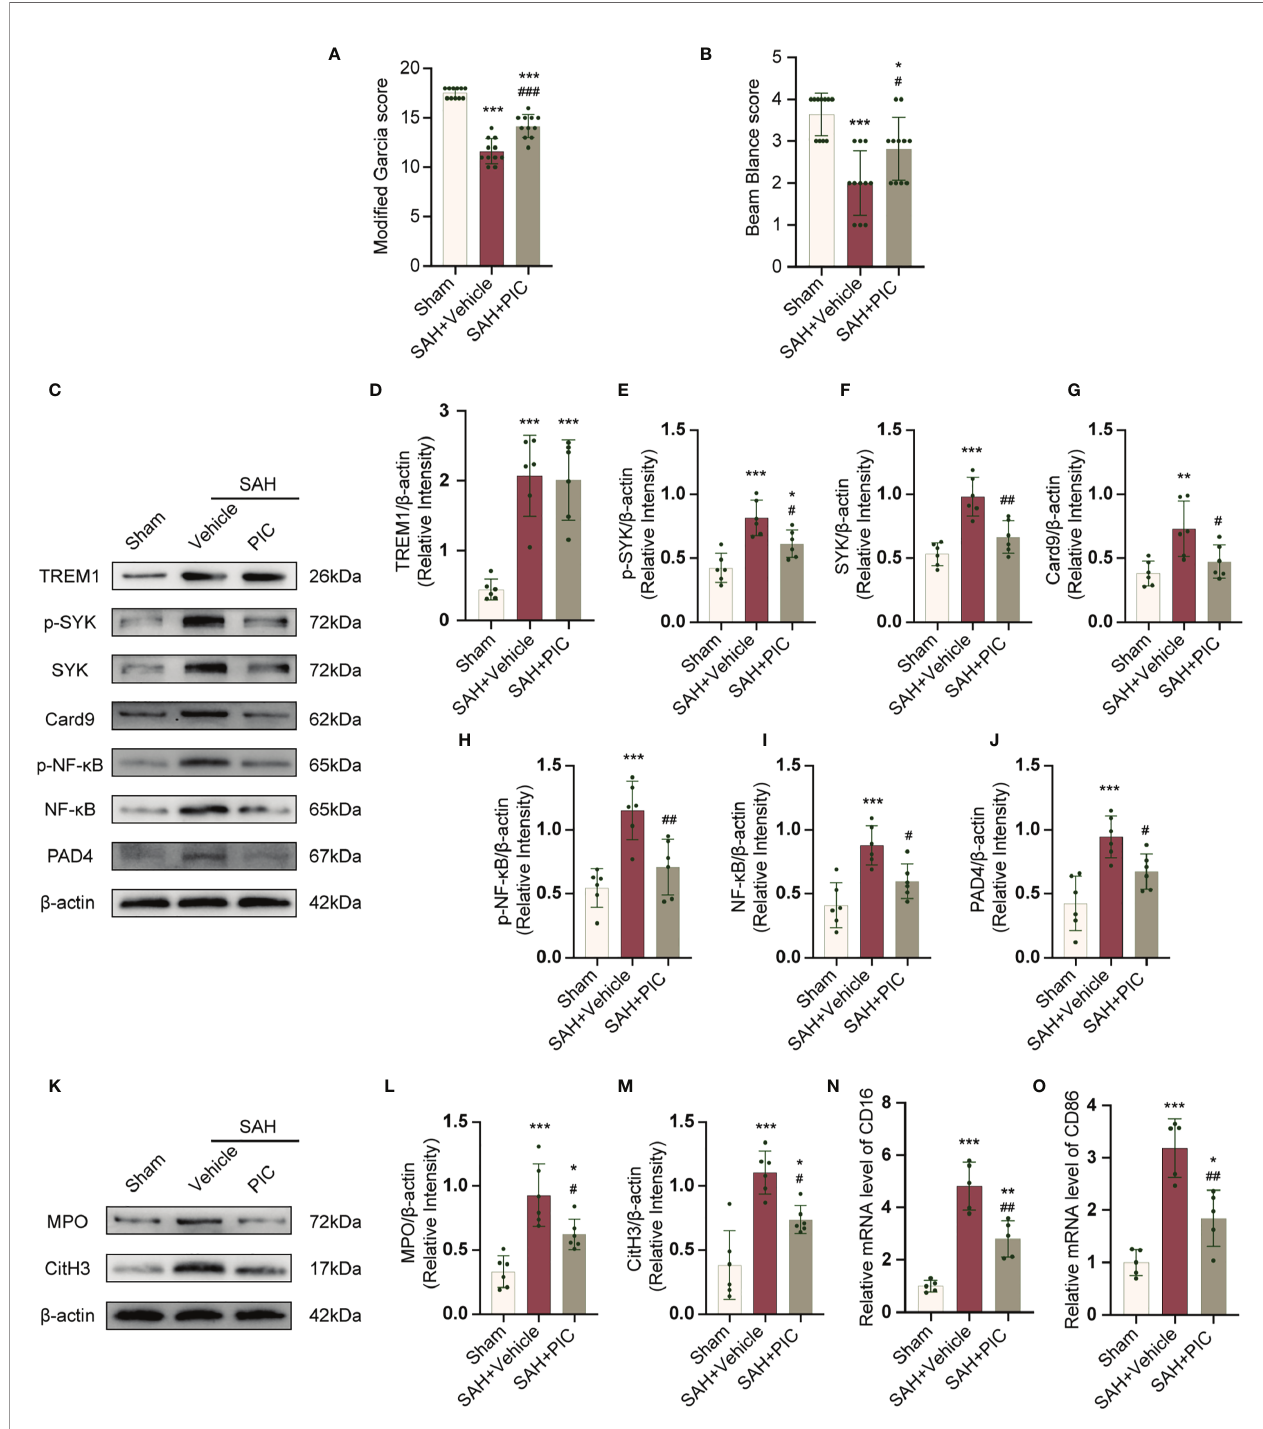
FIGURE 8 | TREM1-induced SYK activation triggered proin fl ammatory subtype microglia and the formation of NETs after SAH. (A, B) Quanti fi cation of neurological function (modi fi ed Garcia score and beam balance test) at 24 h after SAH. n = 11/group. (C – J) Representative western blotting images and quantitative analysis